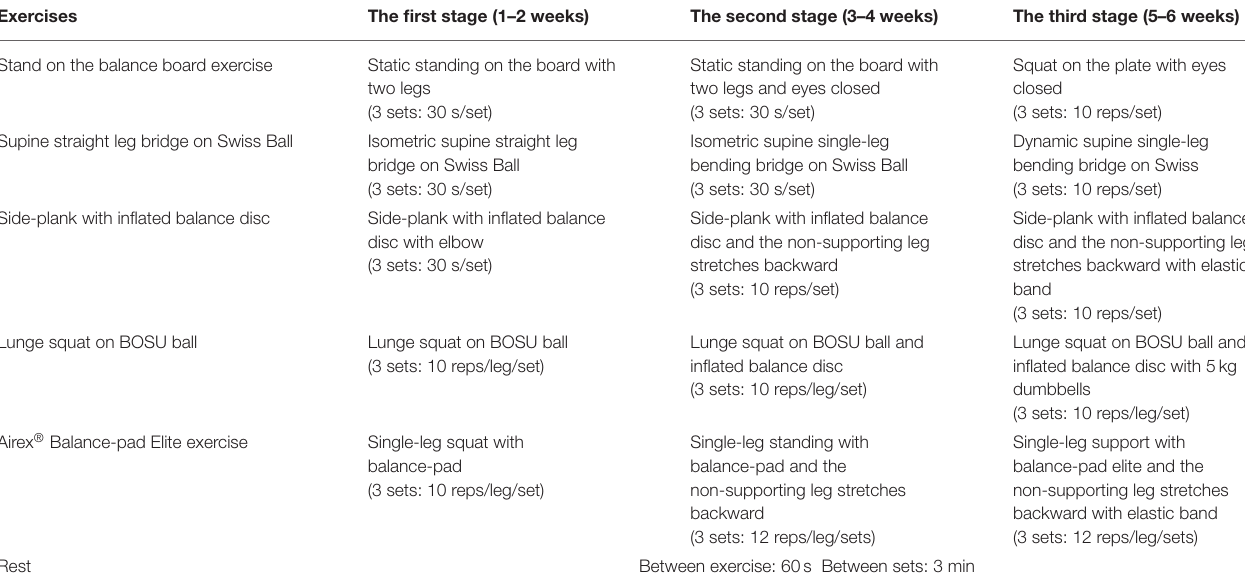
TABLE 1 | The balance training program for balance-plyometric (BP) (combined training) group. Exercises